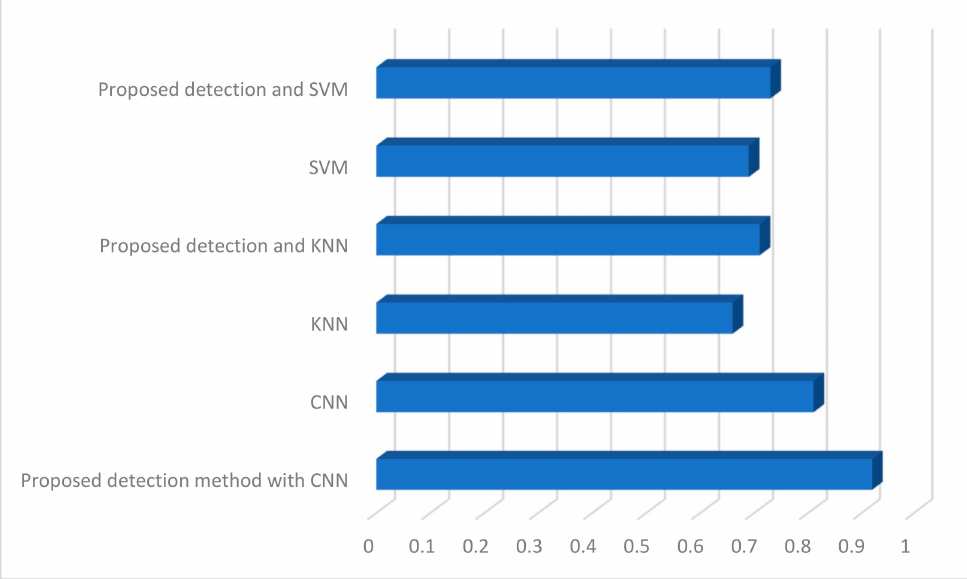
Figure 7. Comparison of di ff erent classification techniques on a selected database. SVM—support vector machine; KNN—k-nearest neighbors; CNN— convolutional neural